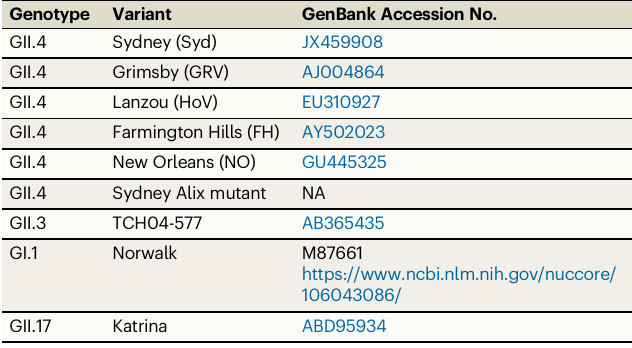
Table 1 | Norovirus VLP speci fi cations